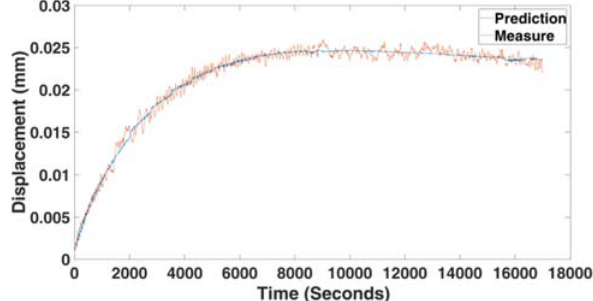
Figure 6. Displacement fit plot of the model predicted displacement value and actual value using the best model parameters.